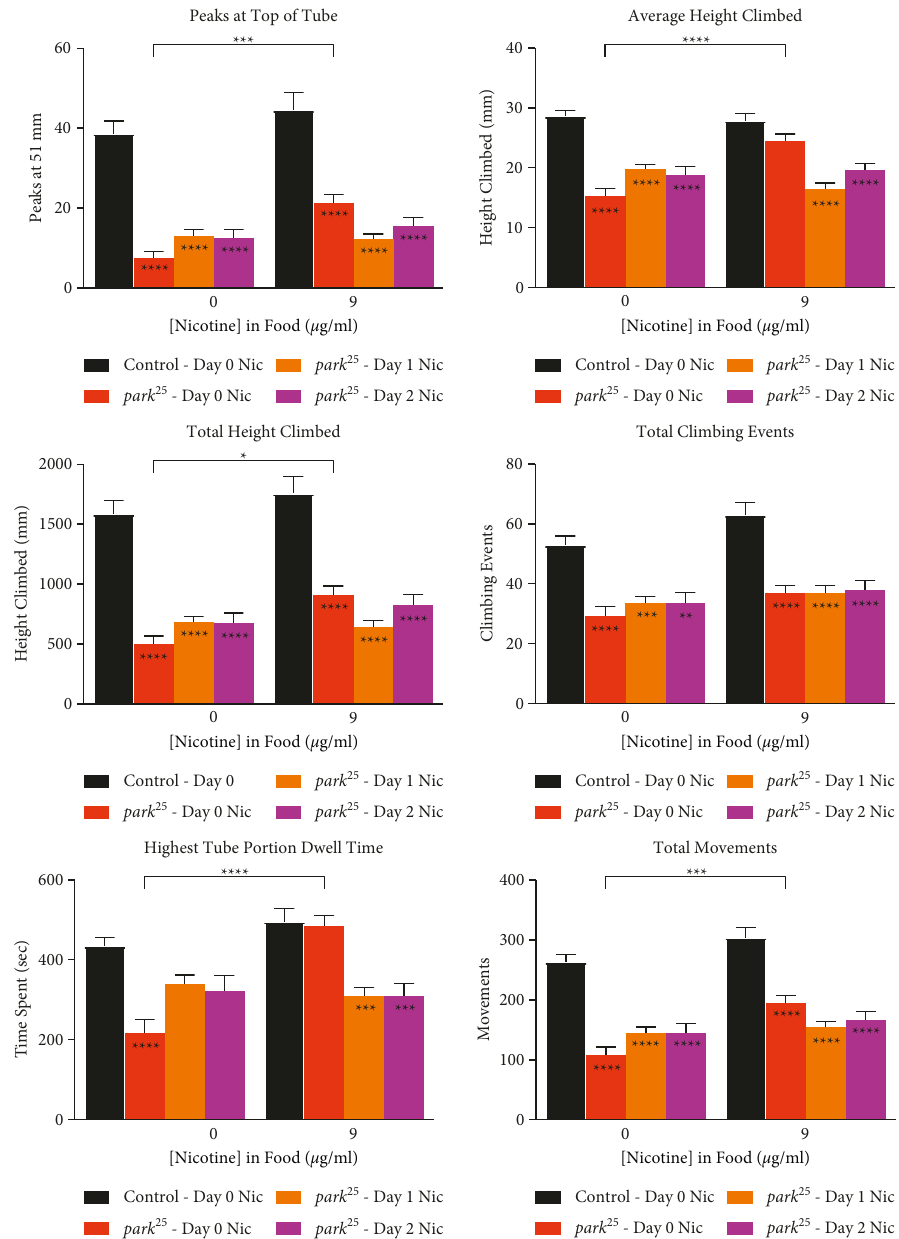
Figure 4: Delayed nicotine does not provide benefits in climbing in homozygous park 25 flies. Nicotine (9 μ g/mL) was given to homozygous park 25 and control flies on day 0 post-eclosion as well as on days 1 and 2 post-eclosion to the park 25 flies. Different climbing metrics are shown, see Methods for definitions. Data are presented as mean and SEM. Results from a post hoc Tukey HSD analysis are shown. Asterisks inside the bars compare between the two genotypes at individual nicotine levels. ∗∗∗∗ � P < 0 . 0001, ∗∗∗ � P < 0 . 001, ∗∗ � P < 0 . 01 ∗ � P < 0 . 05. The results of each data point are from at least four separate experiments with an n ≥ 38